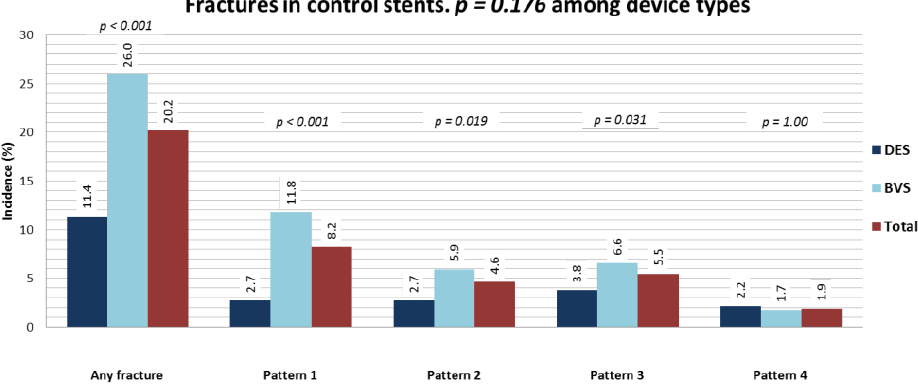
Figure 2. Prevalence of SF, distribution across patterns and differences between stents and scaf- folds.